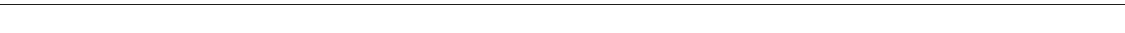
Fig. 5 Structure and dynamics of the dU2A ′ – dSNF 1 – 96 complex. a Crystal structure of the dU2A ′ – dSNF 1 – 96 complex (dU2A ′ - green; dSNF 1-96 - steel blue) in two orientations, superimposed on isolated dSNF 1 – 96 (gray). The orientation of dSNF 1 – 96 in the left panel is identical to the view in Fig. 1b, the orientation of the right view is indicated by the boxed rotation symbols. b dSNF 1-9615 N/ 1 H backbone amide dynamics measured with Δ R 2,eff NMR CPMG experiments. dSNF 1-96 is 300 µ M in 50 mM KCl, 20 mM sodium cacodylate, pH 6.5, in 90% 1 H 2 O, 10% 2 H 2 O; 23 °C; 700 MHz. c 15 N-dSNF 1 − 96 + dU2A ′ (1:1) (220 µ M/ 220 µ M) in 200 mM KCl, 20 mM sodium cacodylate pH 6.5; 23 °C; 700 MHz. Amino acid residues indicated in orange have no detectable signal due to conformational exchange or exchange with proximal protons, hatched bars are line-broadened and not quanti fi able. Errors in ( b ) and ( c ) were determined from the propagation of base plane rms noise. d Orthogonal views of Δ R 2,eff values mapped onto the structure of dSNF 1 – 96 in isolation (top) and bound